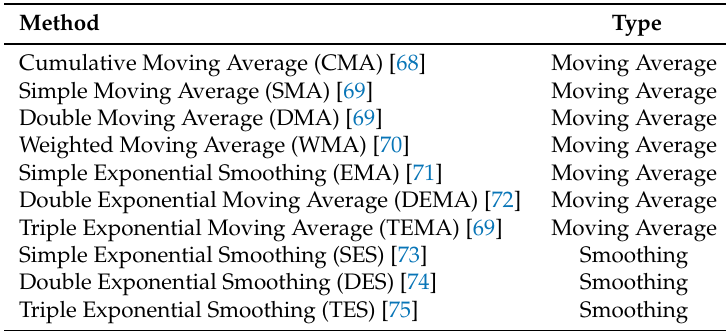
Table 2. Battery of forecasting algorithms.